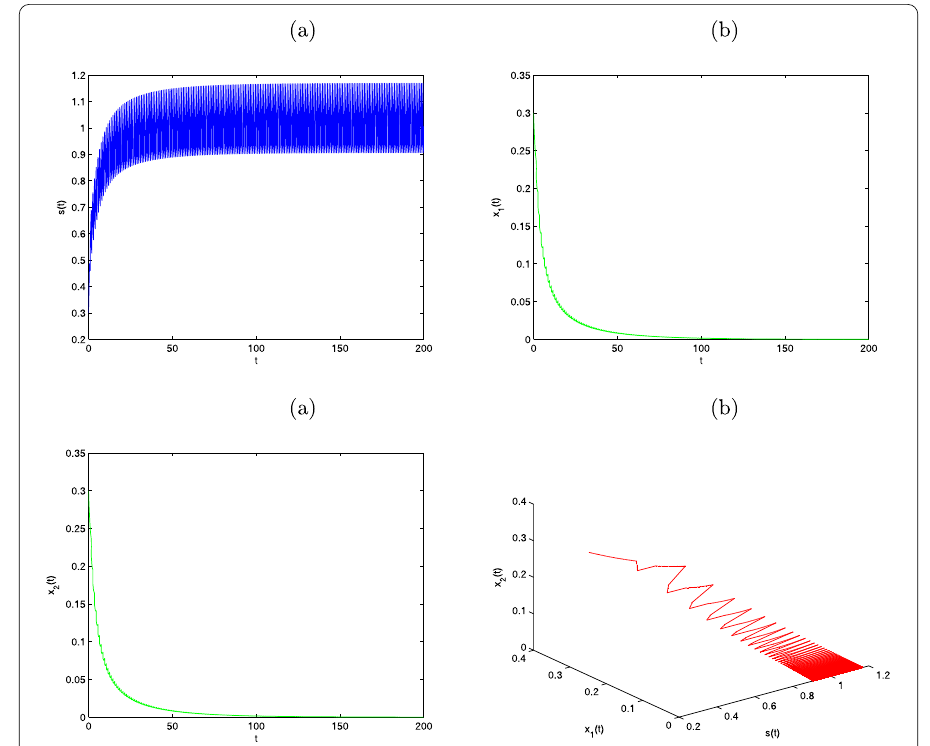
Figure 4 Globally asymptotically stable phytoplankton-extinction periodic solution of system (2.1) with s (0) = 0.3, x 1 (0) = 0.3, x 2 (0) = 0.3, λ 1 = 0.5, d 1 = 0.2, β 11 = 0.5, δ 11 = 1, β 12 = 0.5, δ 12 = 1, d 11 = 0.4, d 12 = 0.4, λ 2 = 0.1, d 2 = 0.2, β 21 = 0.3, δ 21 = 1, β 22 = 0.3, δ 22 = 1, d 21 = 0.3, d 22 = 0.3, E s = 0.3, E 1 = 0.2, E 2 = 0.2, μ s = 0.28,